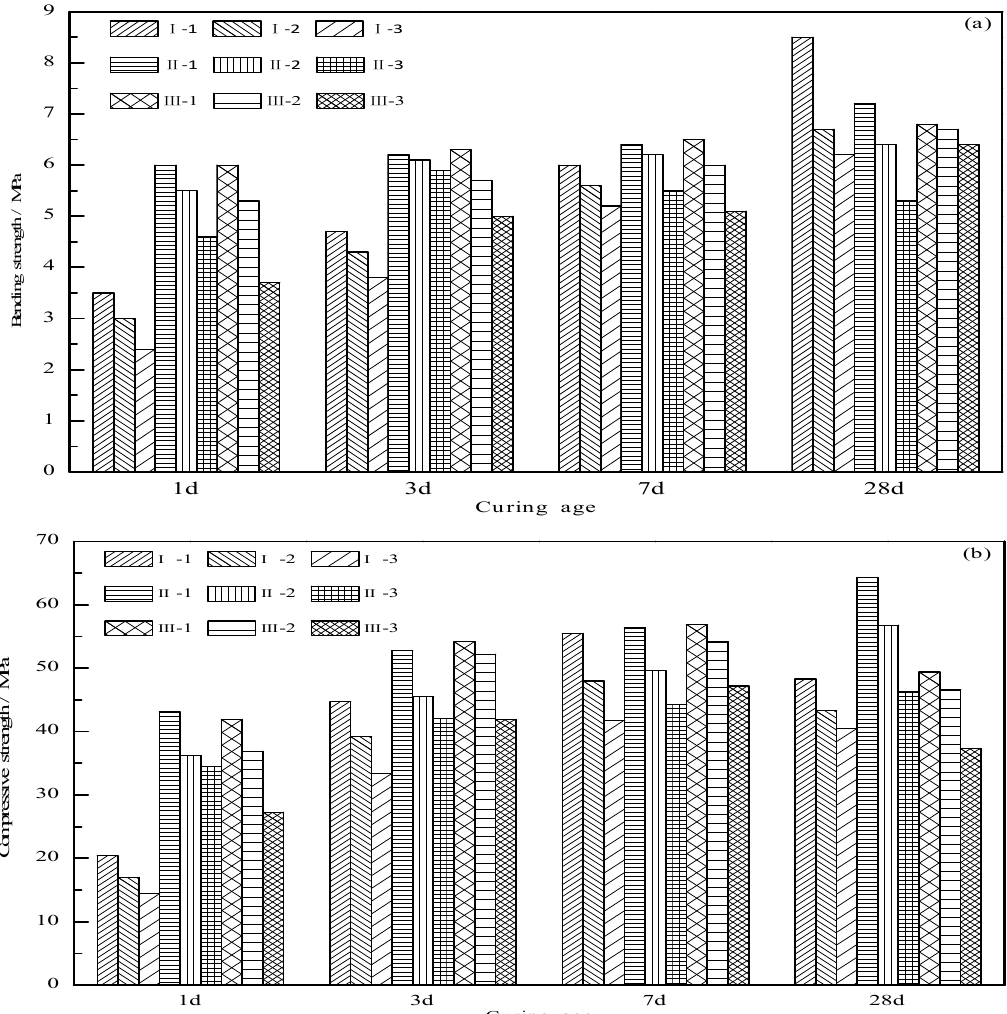
Figure 9. Mechanical strength of the cement clinkers: ( a ) bending strength; ( b ) compressive strength.